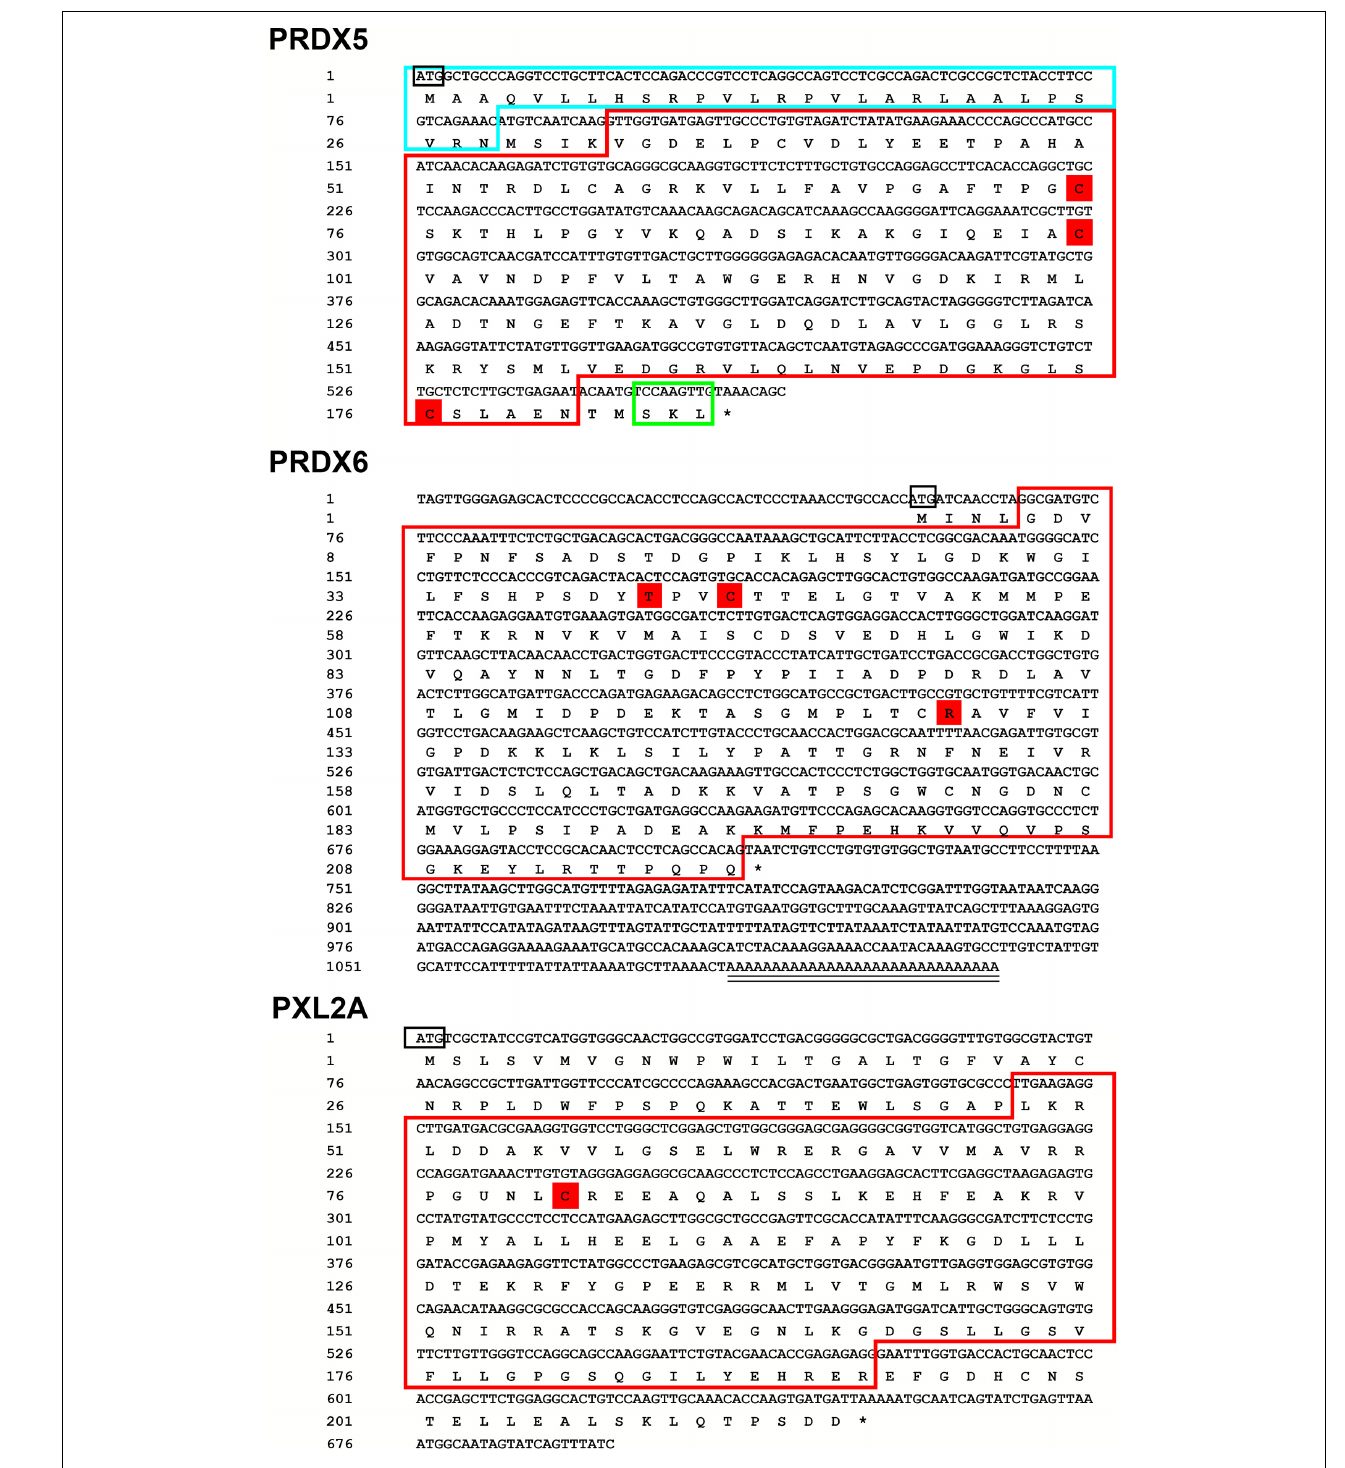
FIGURE 1 | Sequencing results and amino acid sequence analysis of PRDX5, PRDX6, and PXL2A in C. japonica . The start (ATG) and end (TGA) codons are highlighted with a black box. *Denotes the termination codon. The blue boxes indicate possible mitochondrial signaling peptides. The red boxes represent the redoxin domain. The red shade indicates the likely active site, cysteine sulfenic acid (-SOH) intermediate, for peroxidase activity.